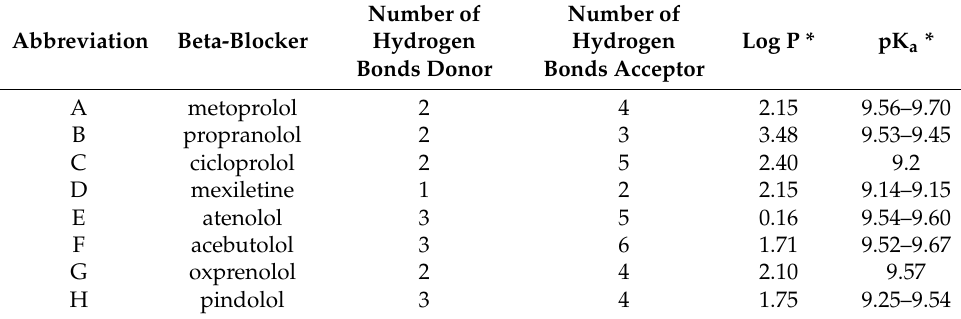
Table 1. Characteristics of compounds used in the